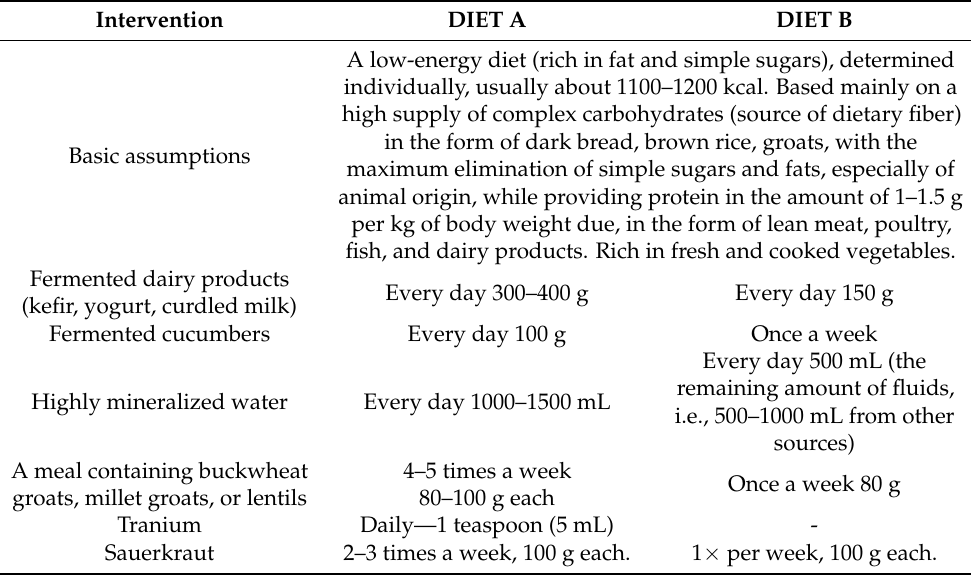
Table 1. Characteristics of the intervention diets.